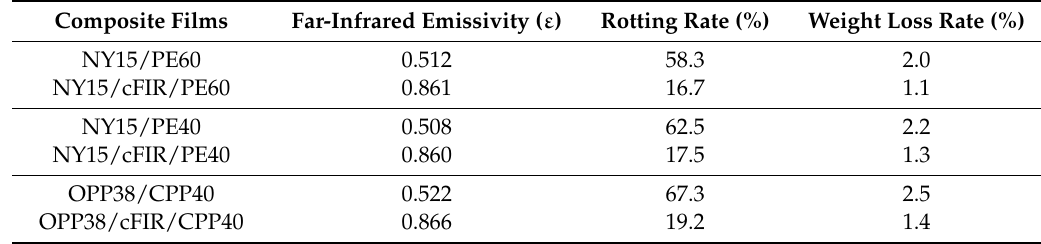
Table 2. Emissivity of cFIR composite films and the effects of packaging on